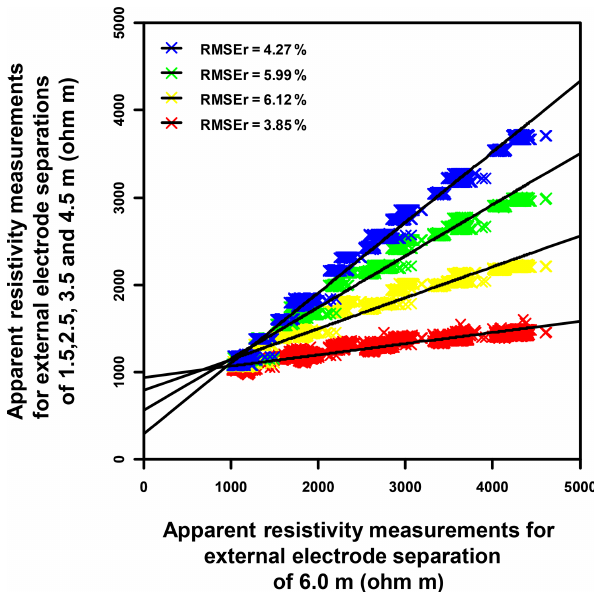
Figure 6. Scatter plot relating the apparent resistivity data corre- sponding to the first pseudo-depth acquisition level with an ES of 2m (external electrode spacing of 6m) vs. the four surficial appar- ent resistivity levels using an ES of 0.5m with external electrode separations of 1.5 (red crosses), 2.5 (yellow crosses), 3.5 (green crosses) and 4.5m (blue crosses) using the Wenner–Schlumberger array for the 25 synthetic resistivity models. Each point of the scat- ter plot represents the apparent resistivity of one synthetic model, for the same pseudo-x position, but at different pseudo-depths as defined by the external electrode separation (see Sect. 2.3 for more details). The linear regressions correspond to the thick black lines and their accuracy is indicated by the root mean square relative error (RMSEr).